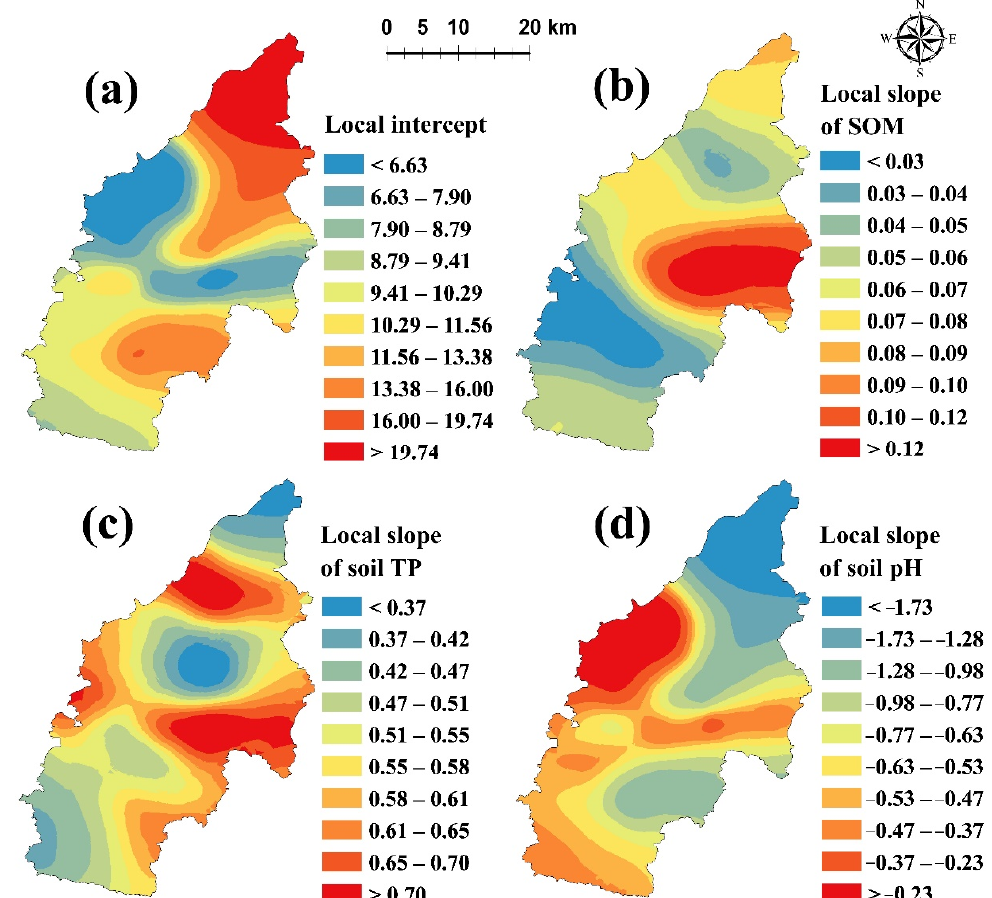
Figure 3. Spatial distribution maps of local regression coefficients generated by robust geographically weighted regression (RGWR) analysis of wheat yield against three explanatory variables: ( a ) local intercept, ( b ) local slope of soil organic matter (SOM), ( c ) local slope of soil total phosphorus (TP), and ( d ) local slope of soil pH.